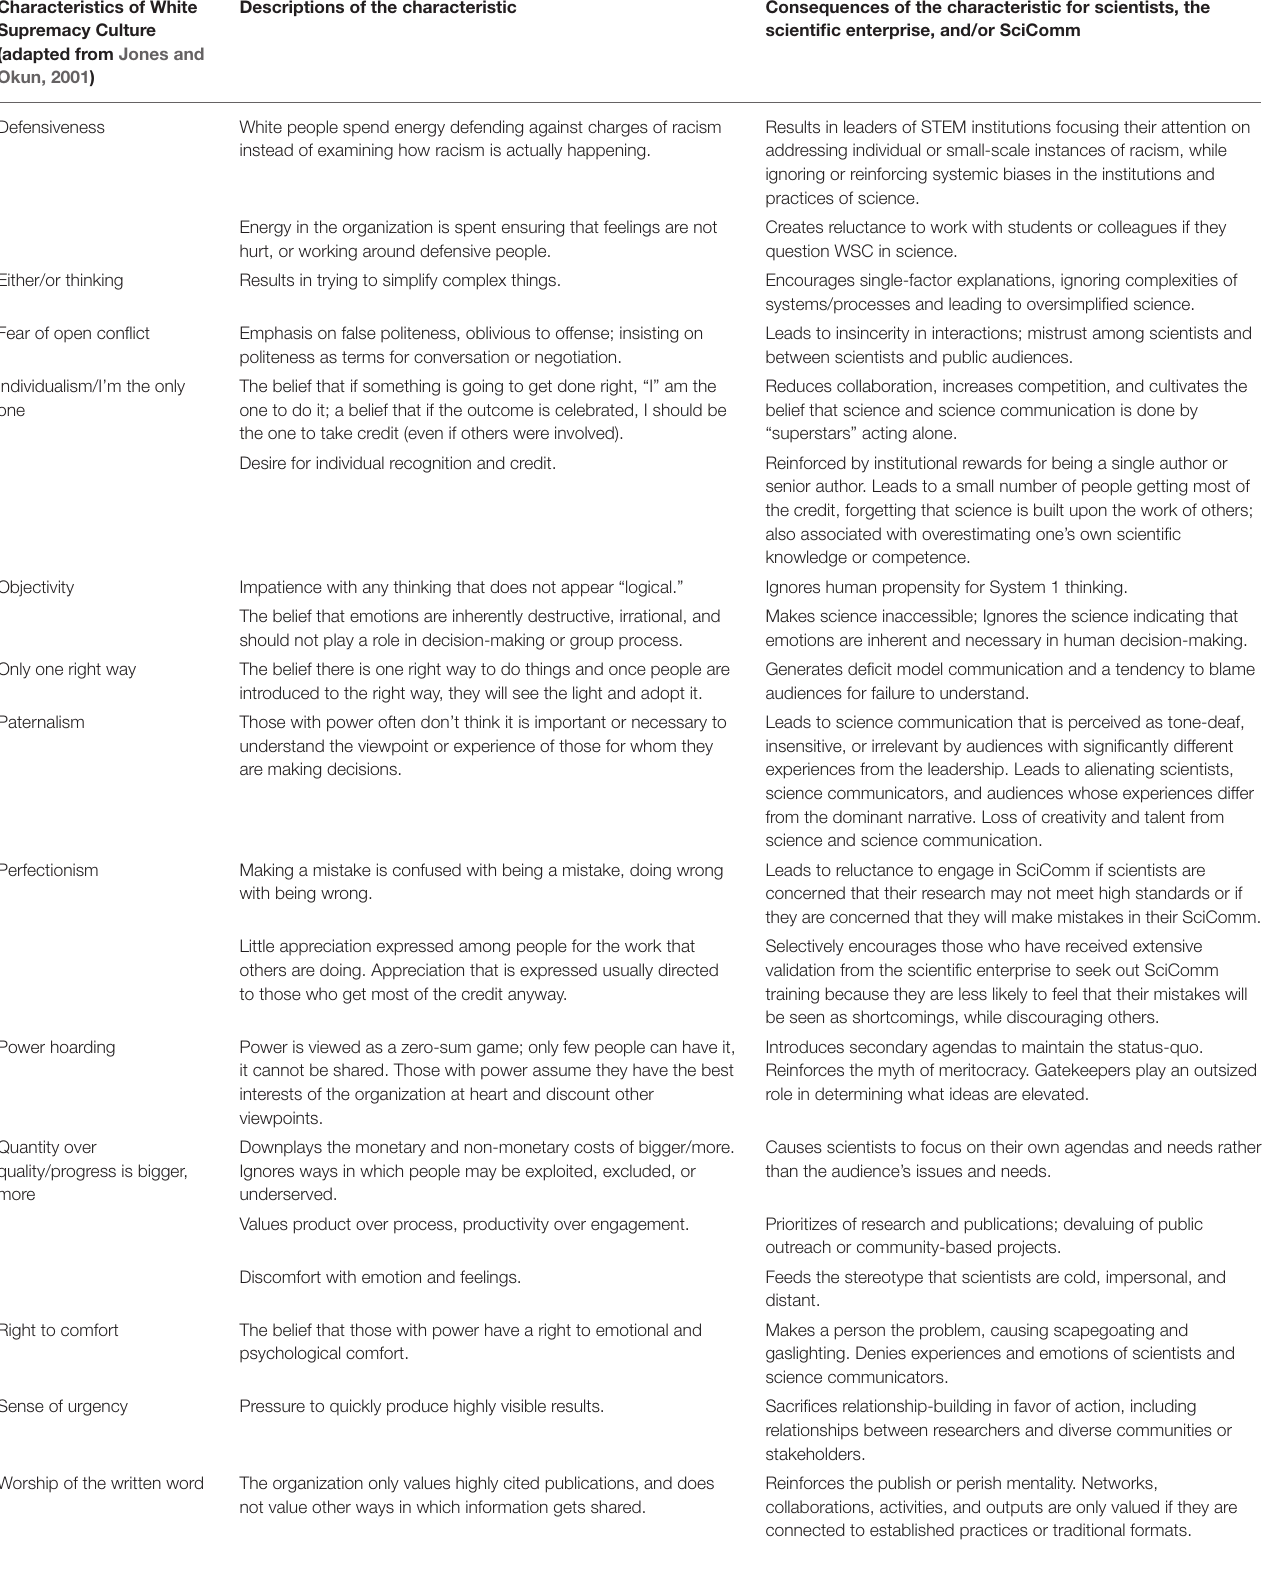
TABLE 1 | List of White Supremacy Culture characteristics identified by Jones and Okun (2001) and examples of how these show up in STEM fields. Descriptions of the characteristic Characteristics of White Supremacy Culture (adapted from Jones and Okun, 2001)